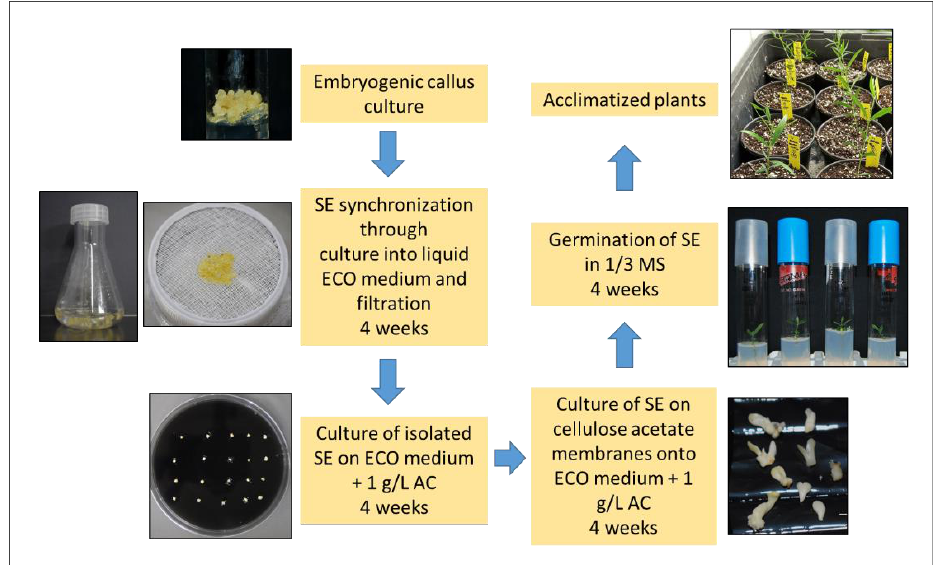
Figure 1. Images of the steps of olive somatic embryos (SE) maturation and plant regeneration protocol [28]. protocol